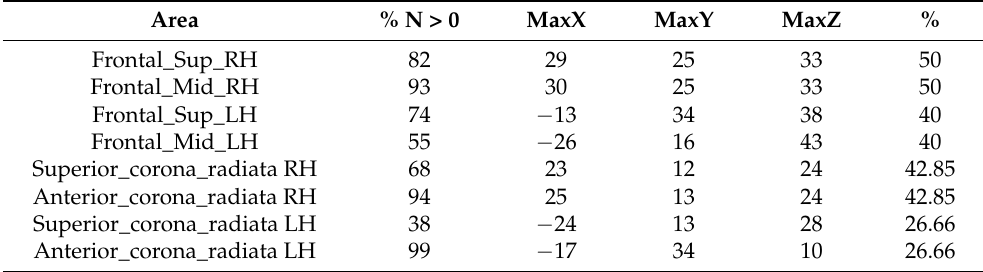
Table 3. Spatial coordinates, according to the Montreal Neurological Institute space system, of the brain areas listed in the first column, with the worst damage, as evidenced by the percentage lesion overlay indicating the percentage of patients with a lesion maximally localized in the listed